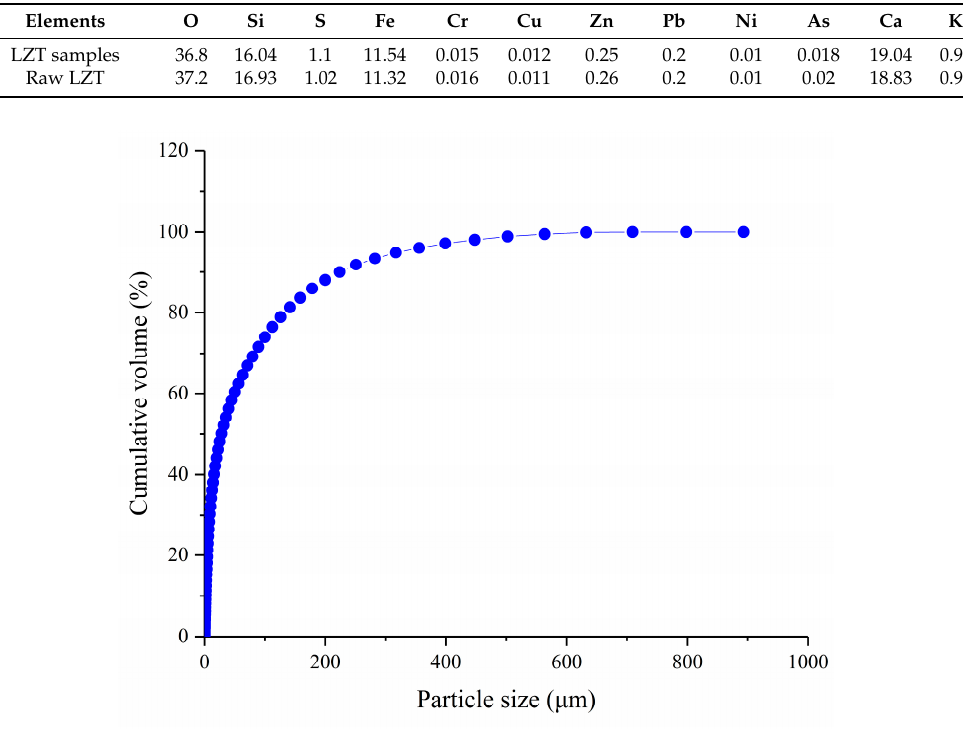
Figure 2. Particle size distribution of lead–zinc tailing (LZT). Table 2. Chemical composition of lead–zinc tailing (LZT) (wt%).